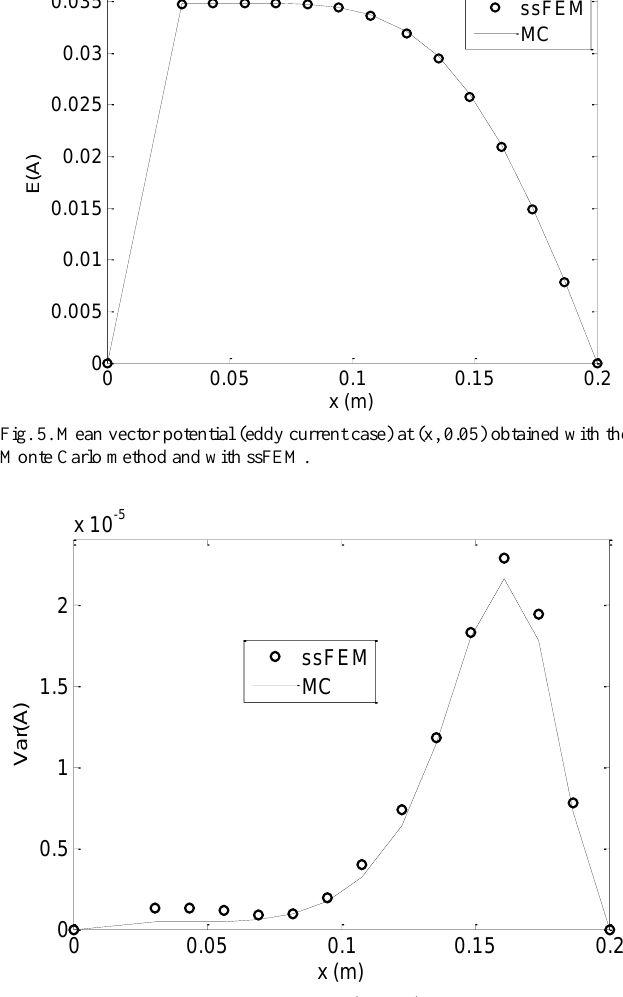
Fig. 6. Variance of the vector potential at (x, 0.05) obtained with the Monte Carlo method and ssFEM. With this problem, only the ssFEM and the Monte Carlo method were chosen to be compared, mainly due to the difficulty of obtaining analytical solutions to eddy current problems. Fig 5 shows the expected absolute values of the vector potential along the same ( x , 0.05) line as before. Monte Carlo results from 1000 simulations are shown with the solid line, while the circles show the ssFEM results with P = 5. Again, a very good agreement can be observed between the different methods.